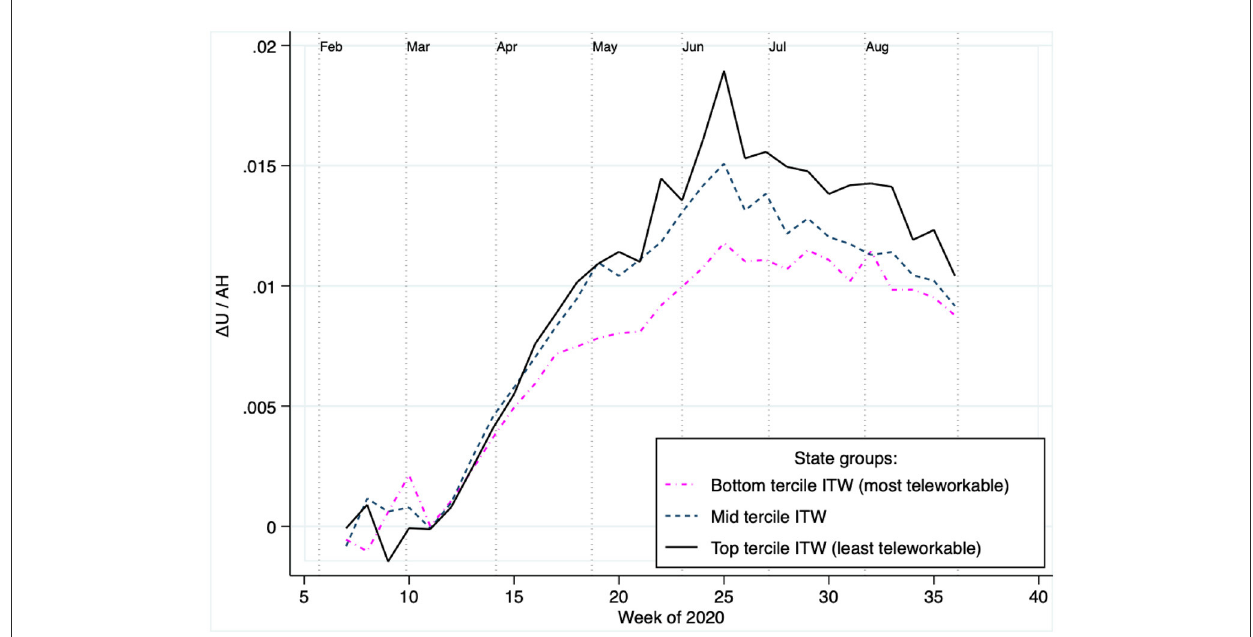
FIGURE3 The teleworkability channel: Those states with higher teleworkability exhibited less abnormal unemployment per point of mobility reduction. Plots the amount of abnormal 2020 unemployment per point of abnormal mobility reduction (stay-at-home), aggregated across groups of states based on their teleworkability levels. The figure’s main pattern indicates that in states with higher teleworkability there was less abnormal unemployment per point of mobility